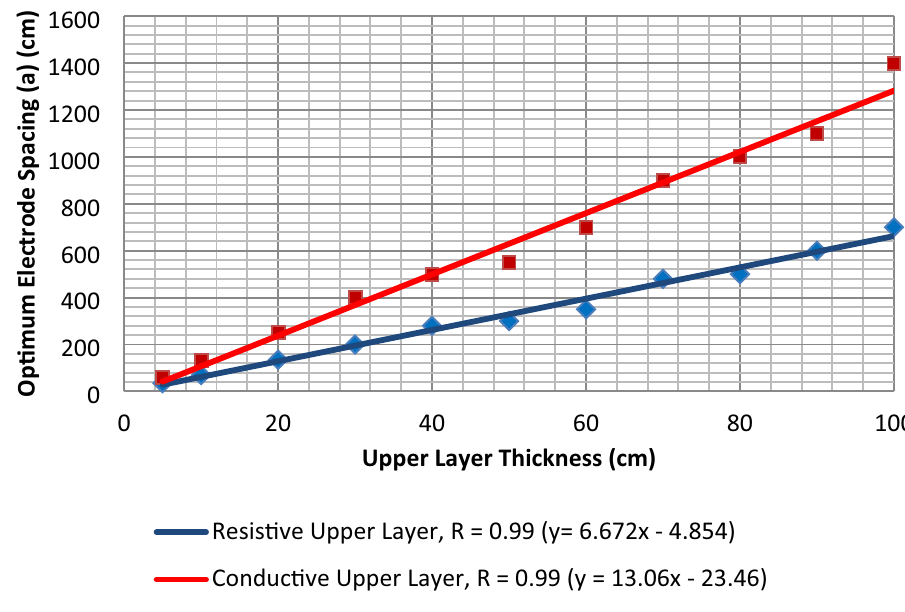
Fig. 9 Analytical chart for deterministic electrode